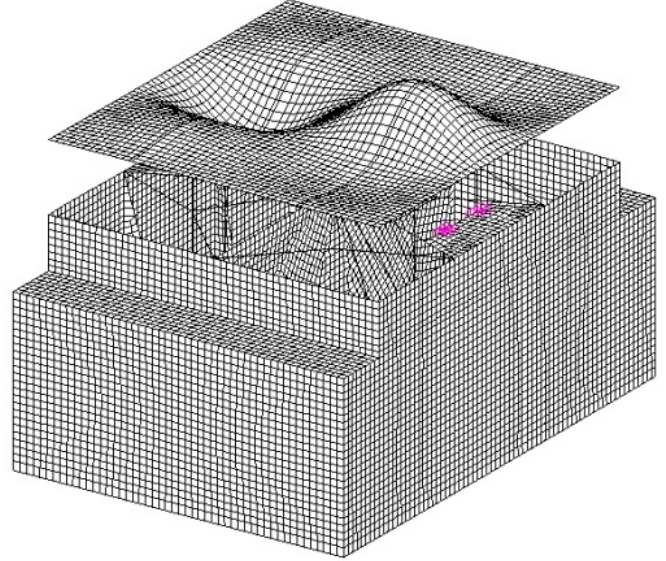
Figure 12. Displacement results of the